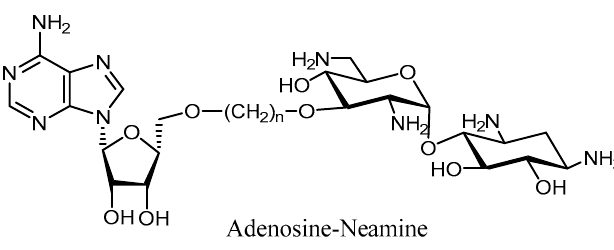
Figure 11. Structure of nucleotide-neamine complex as inhibitor of APHs and ANTs.